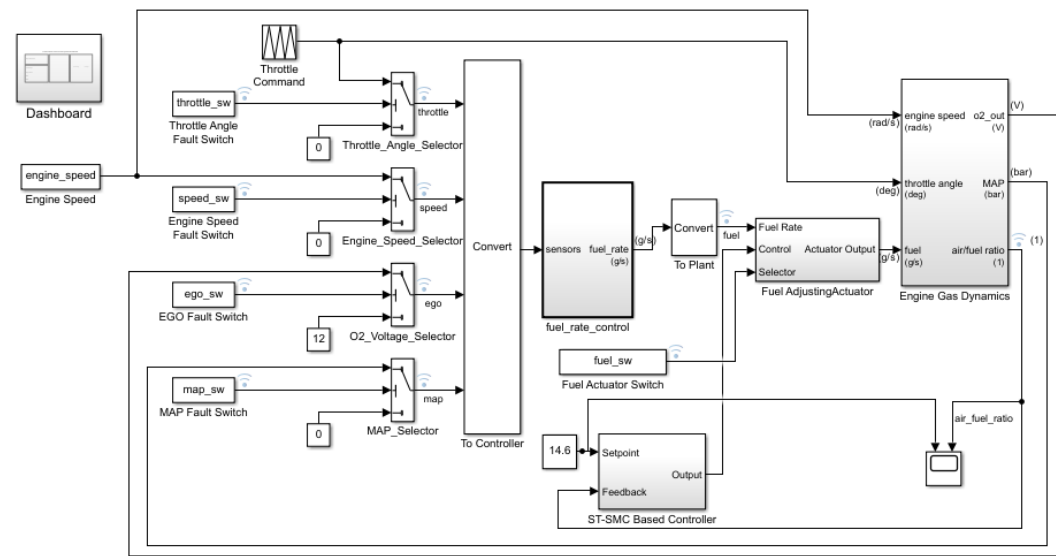
Figure 12. Performance of AFTCS.